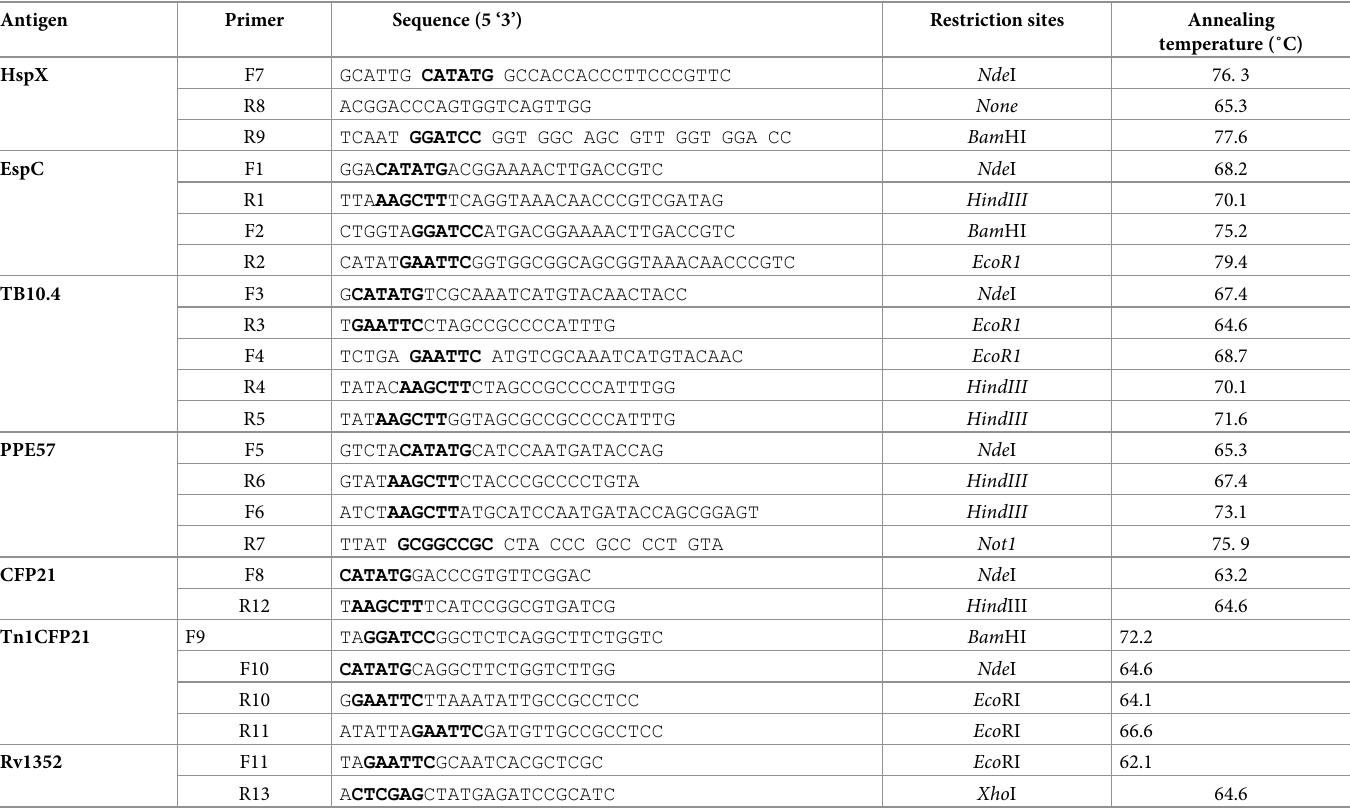
Table 1. Primers for PCR amplification with the restriction sites shown in bold.